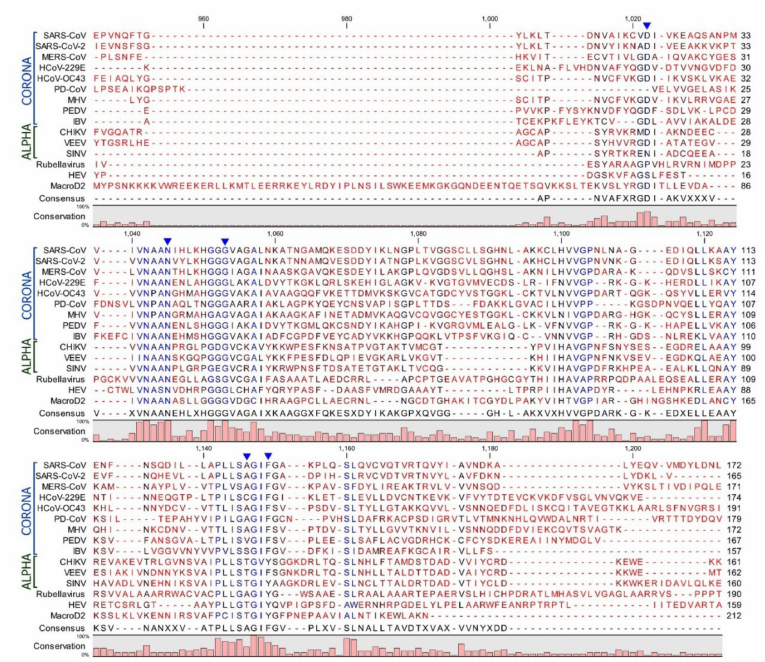
Figure 2. Sequence alignment of the amino acid sequences of various viral macrodomains from coronaviruses, alphaviruses, rubellavirus, and hepatitis E virus: The human macroD2 protein sequence was included for comparison. Sequences of viral and human macrodomains were alignment using CLC Genomics Workbench software. Arrows indicate residues that are discussed in the